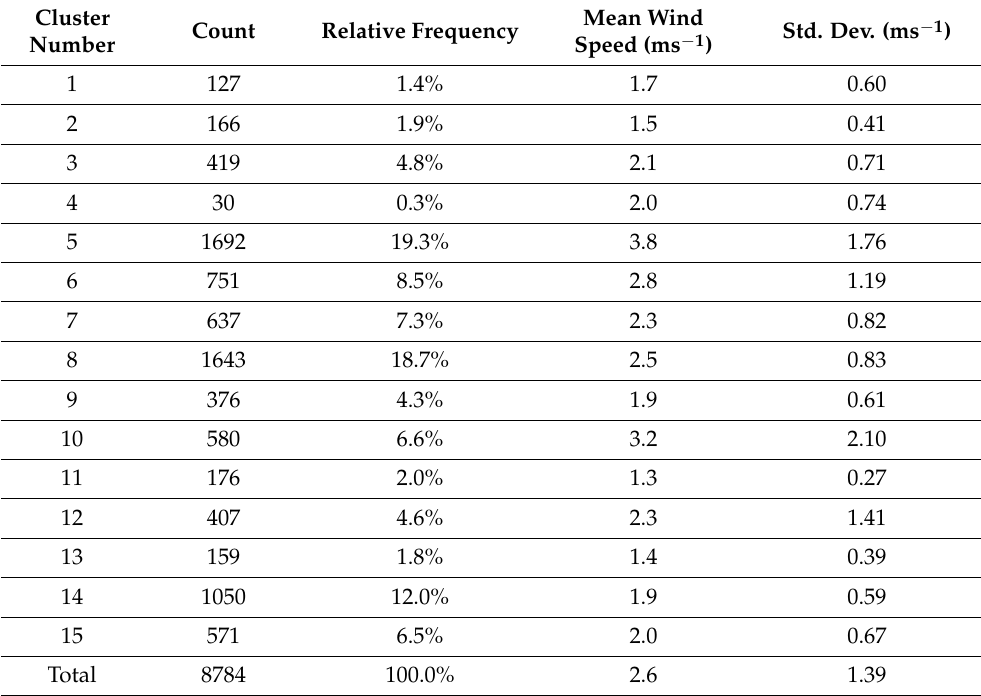
Table 7. Summary of the 15 clusters obtained by the complete linkage clustering method [23].